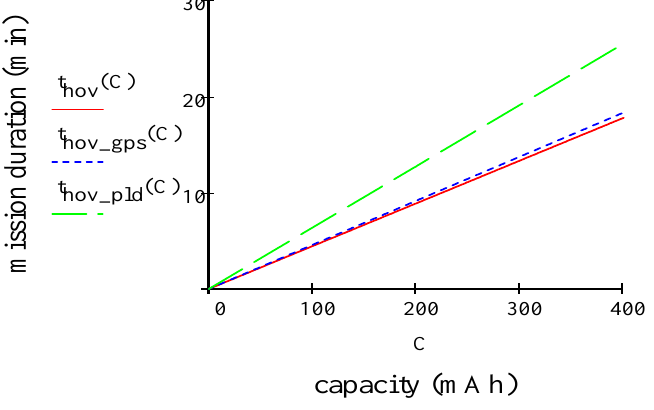
Figure 1. Mission duration vs capacity.